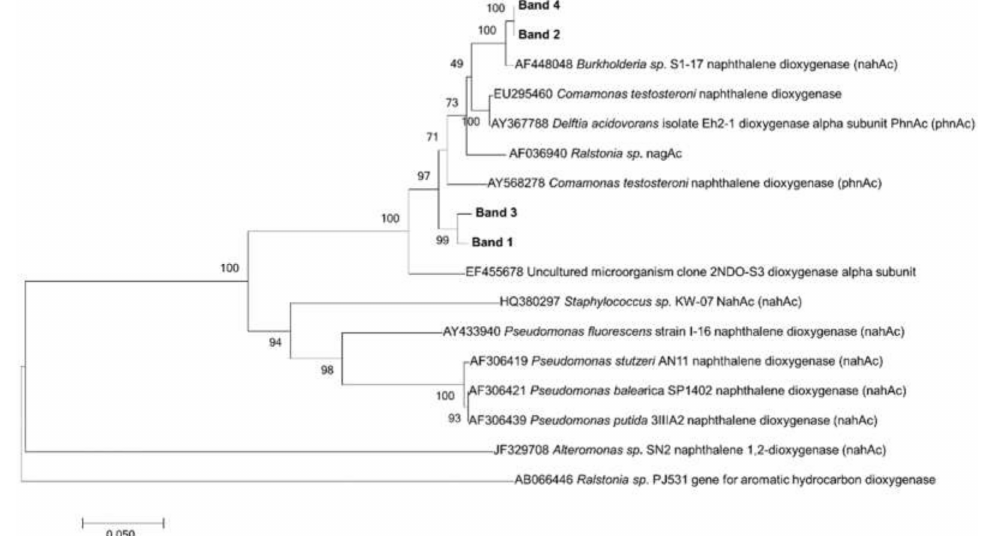
Figure 3. Phylogenetic affiliation of predicted naphthalene dioxygenase amino acids sequence from bands excised from denaturing gradient gel electrophoresis (DGGE) of ndo genes. Bootstrap values ( n = 1000 replicates) are shown next to each